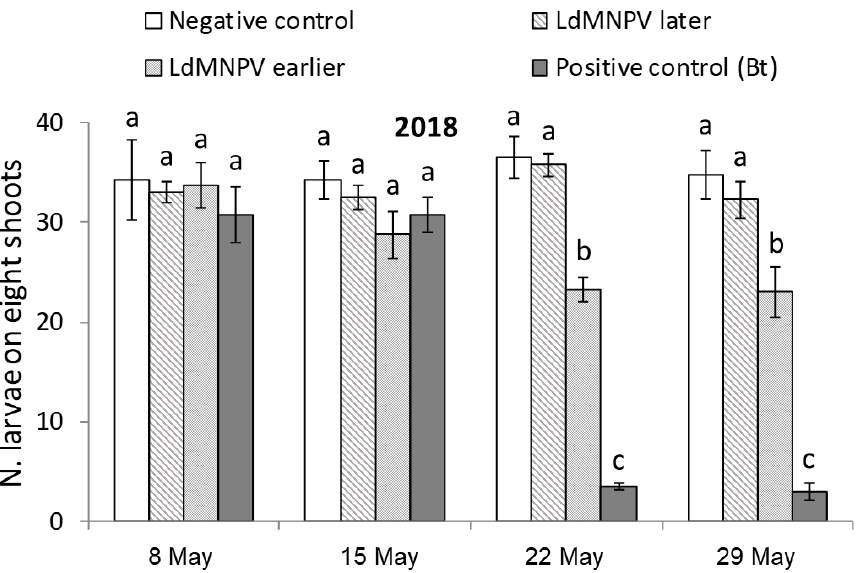
Figure 1. Larval density (mean ± SE) assessed by sampling 8 shoots/plot in the time–response trial with LdMNPV applications from the ground in 2018. Different letters (a, b, c) above bars indicate significant differences among means within each sampling date (ANOVA Mixed Proc., LSMEANS, p <